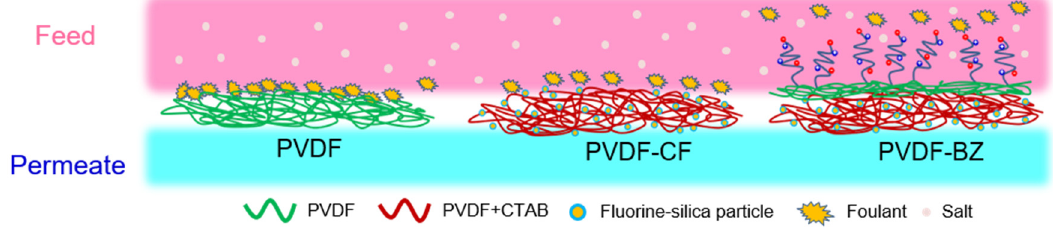
Figure 1. Schematic representation of the polyvinylidene difluoride (PVDF), PVDF-CF, and PVDF-BZ membrane structure.